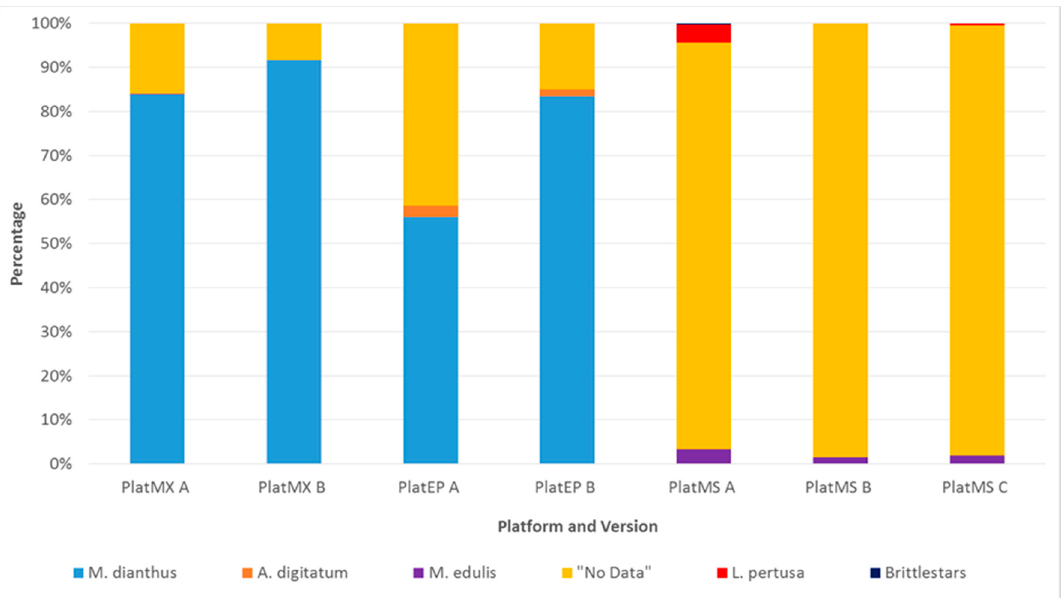
Figure 3. Percentage of correctly identified (by software) annotation points per platform and method, separated by species/labels. Graph only shows proportion of correctly identified species and is not calculated in relation to the total number of points.